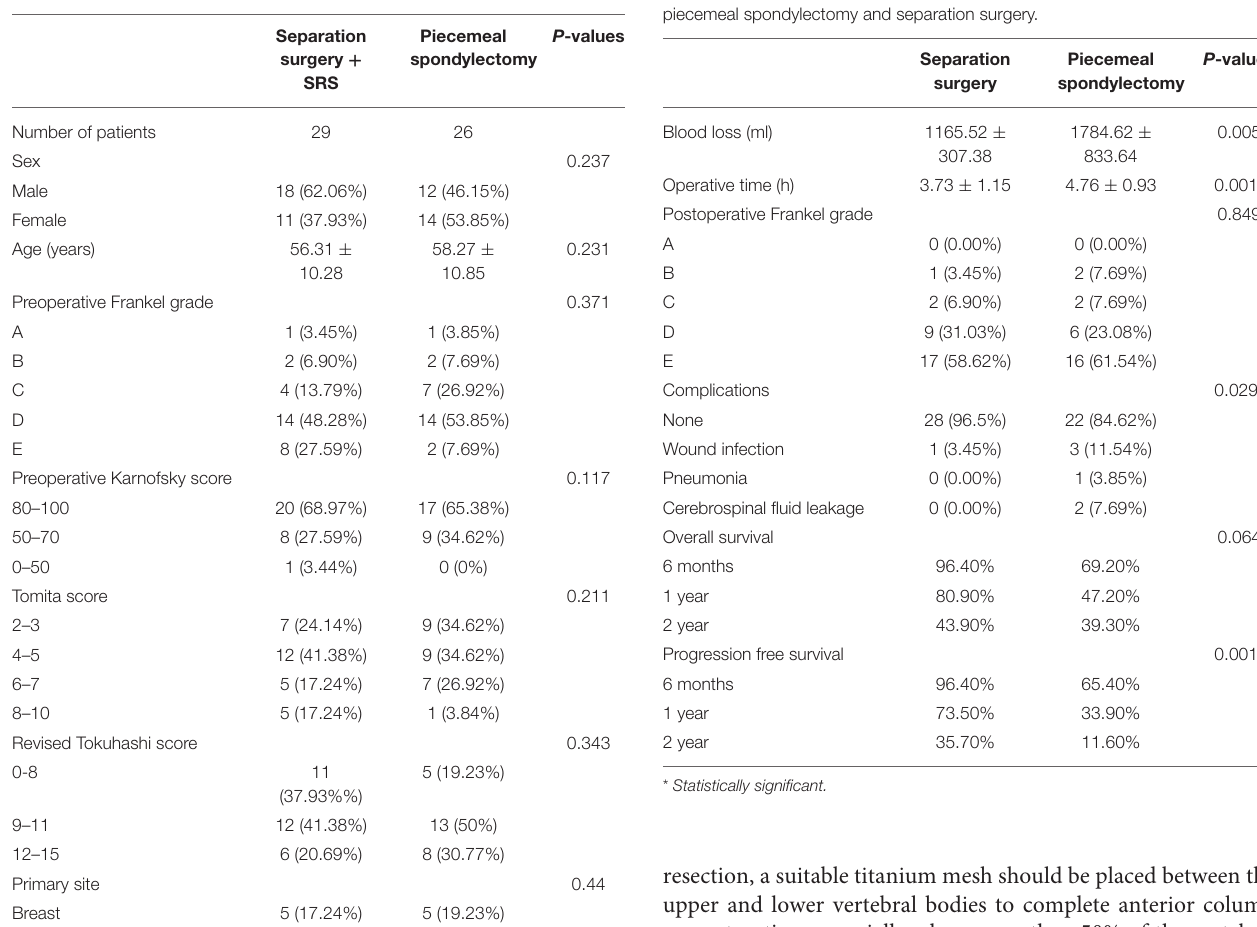
TABLE 1 | Baseline characteristics of patients.